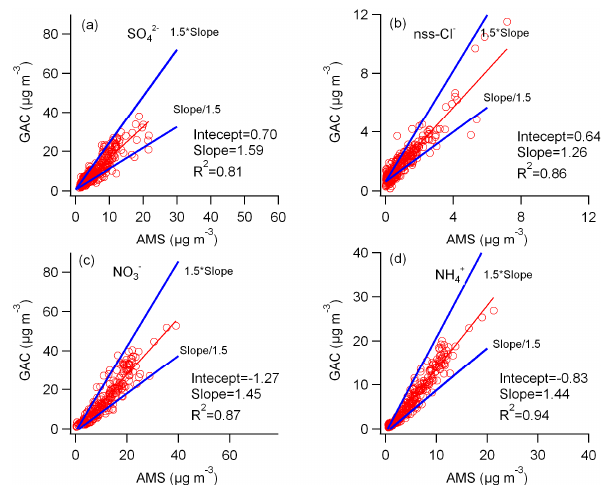
Fig.15. Inter-comparisons between GAC-IC and AMS measured with RH below 50%. Fig. 15. Inter-comparisons between GAC-IC and AMS measured We use 1-hour average data for the inter-comparisons. with RH below 50%. We use 1-h average data for the inter-